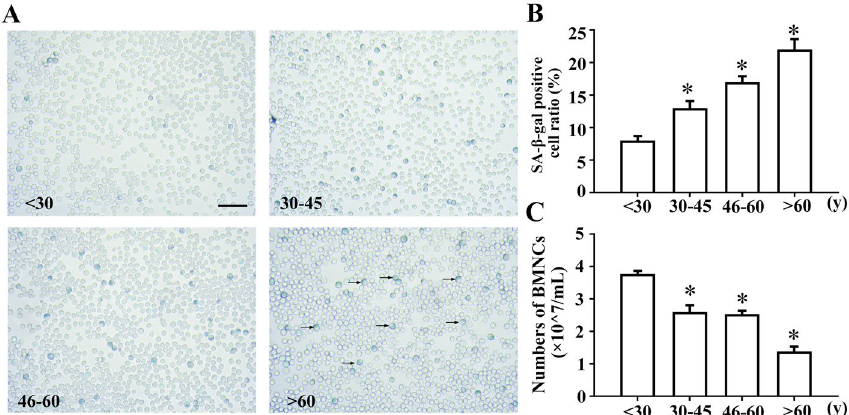
Figure 1. Aging of hBMHCs in different age groups. ( A ) Representative image of the SA-β-gal staining. ( B ) Graphical representation of the enumeration of SA-β-gal positive cells in each group. ( C ) hBMHC count in different age groups (× 10 7 /mL), * p < 0.05: compared with that in the < 30 years group. Bar = 50 μm. “ → ”: positive